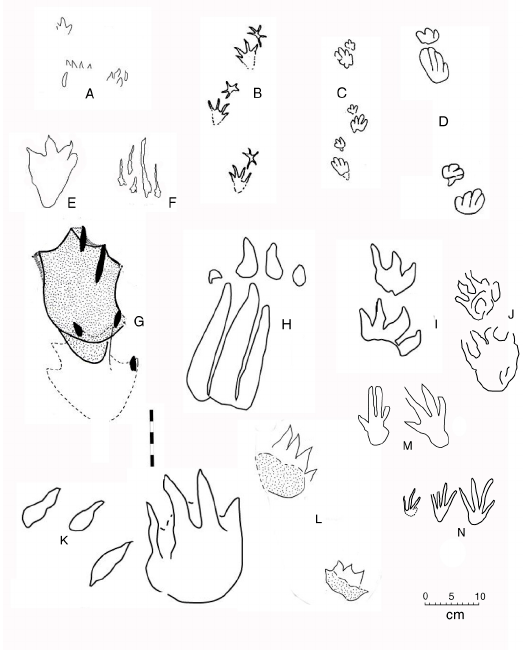
Figure 17. Outlines of crocdylian tracks of Mesozoic and Cenozoic age. A . Early Cretaceous Laiyangpus , China [51]; B . Late Jurassic Crocodylopodus [46]; C . Early Cretaceous, Thailand [53]; D . Early Jurassic Batrachopus [47]; E . Late Jurassic, Portugal [52]; F . Miocene, Characichnos , Czech Republic [42]; G . mid-Cretaceous, Mehiella , USA [48]; H . Paleocene Albertasuchipes , Canada [3]; I . Late Jurassic Hatcherichnus , USA [50]; J . Late Paleocene Borealosuchipes , USA [4]; K . Late Cretaceous, USA [49]; L . Middle Jurassic, Kuanguanopus China [51]; M . Oligocene, Indosuchipes , [54]; N . Anticusuchipes amnis Mustoe, ichnogen. and ichnosp. nov., Eocene, northwest